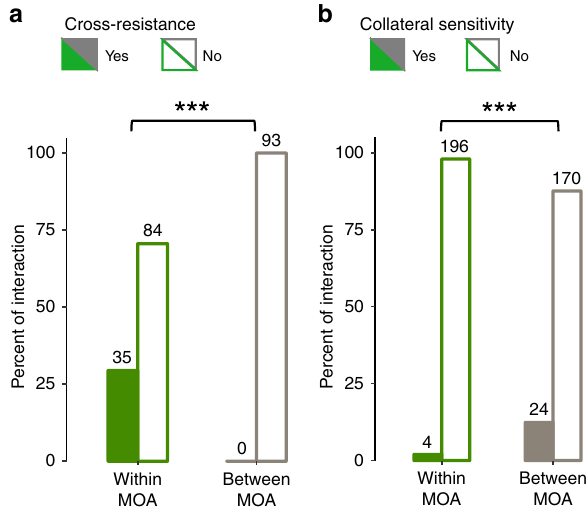
Fig. 6 Mode of action informs on cross-resistance spectra of AMP- evolved lines. a Cross-resistance interactions (i.e., de fi ned as 2-fold increase in MIC) are signi fi cantly overrepresented between AMP pairs either from the group of exclusively membrane-targeting AMPs (TPII, CP1, PGLA, LL37, PEX) or from the group of exclusively intracellular-targeting AMPs (PR39 and BAC5) as compared to pairs of AMPs between the two mode of action groups (MOA). Signi fi cant difference: *** P = 1.333 × 10 − 10 from two-sided Fisher ’ s exact test, n = 119 and 93 for within and between mode of action groups, respectively. b Collateral-sensitivity interactions (i.e., de fi ned as ≥ 20% decrease in MIC) are overrepresented between the groups of membrane-targeting and intracellular-targeting AMPs (i.e., between MOA). Signi fi cant difference: *** P = 4.83 × 10 − 5 from two-sided Fisher ’ s exact test, n = 200 and 194 for within MOA and between MOA, respectively. Source data are provided as a Source Data fi